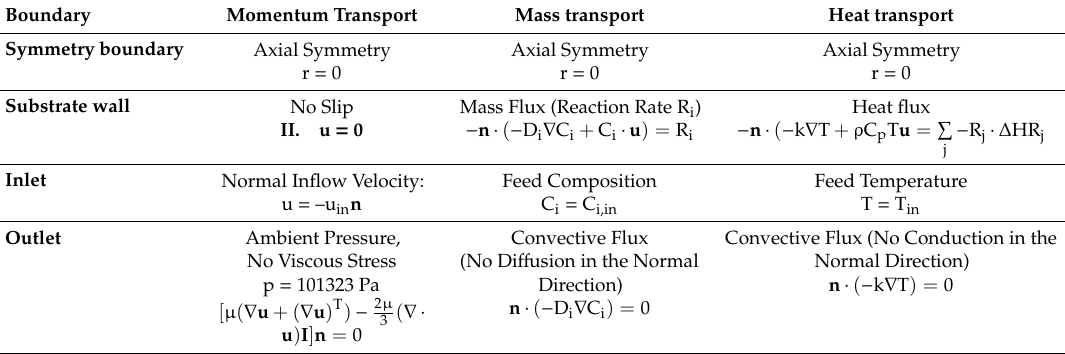
Table 2. Boundary conditions for the momentum, mass and heat transport in the non isothermal 2-D CFD